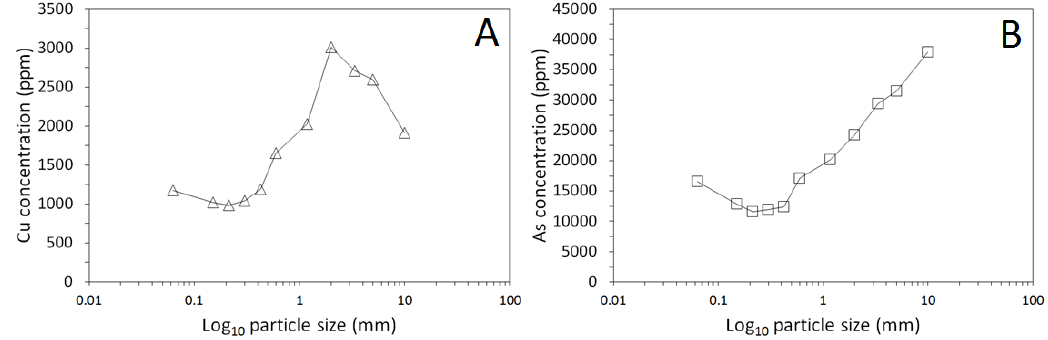
Figure 4. Cu ( A ) and As ( B ) concentrations as a function of particle size.